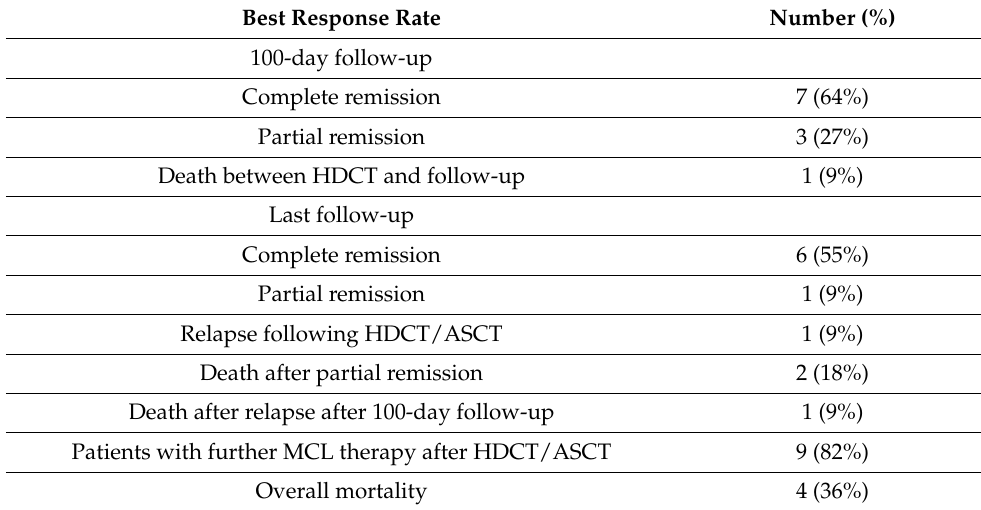
Table 4. Clinical course after HDCT/ASCT.